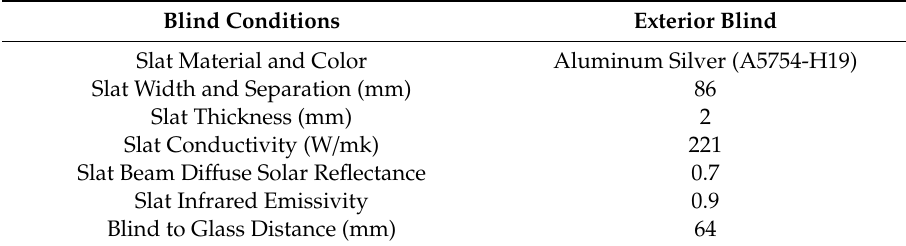
Figure 7 show the values and characteristics of the blinds, as well as on-site images. Table 4. Characteristics of the blind. Table 4. Characteristics of the blind. Table 4. Characteristics of the blind. Table 4. Characteristics of the blind. Table 4. Characteristics of the